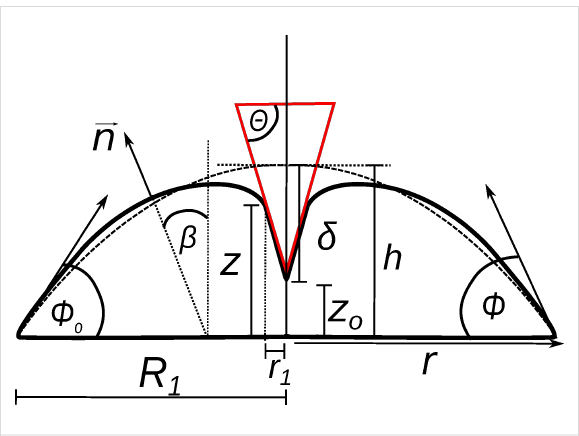
Figure 4: An adherent cell or apical membrane of an epithelial cell in confluent environment represented by a spherical cap (dotted line) subject to indentation using a conical indenter (continuous line). Illus- tration of parameters used in the tension model